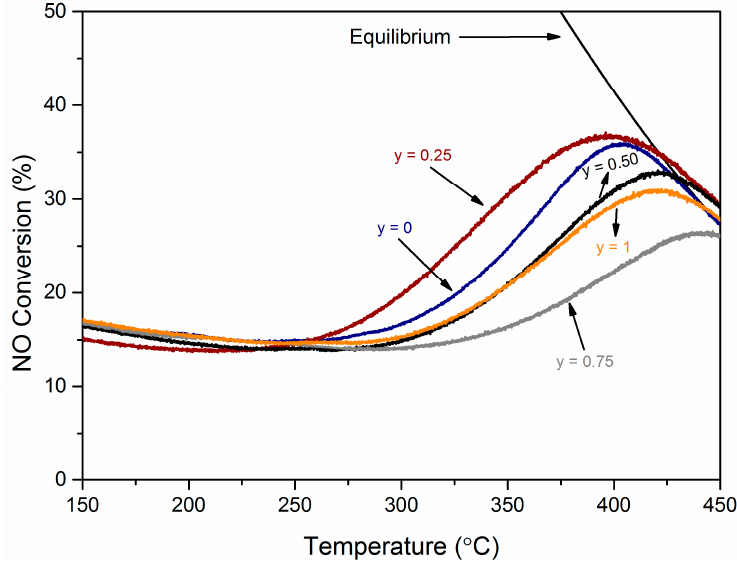
Figure 7. Conversion of NO over LaCo 1 – y Ni y O 3 as a function of temperate.